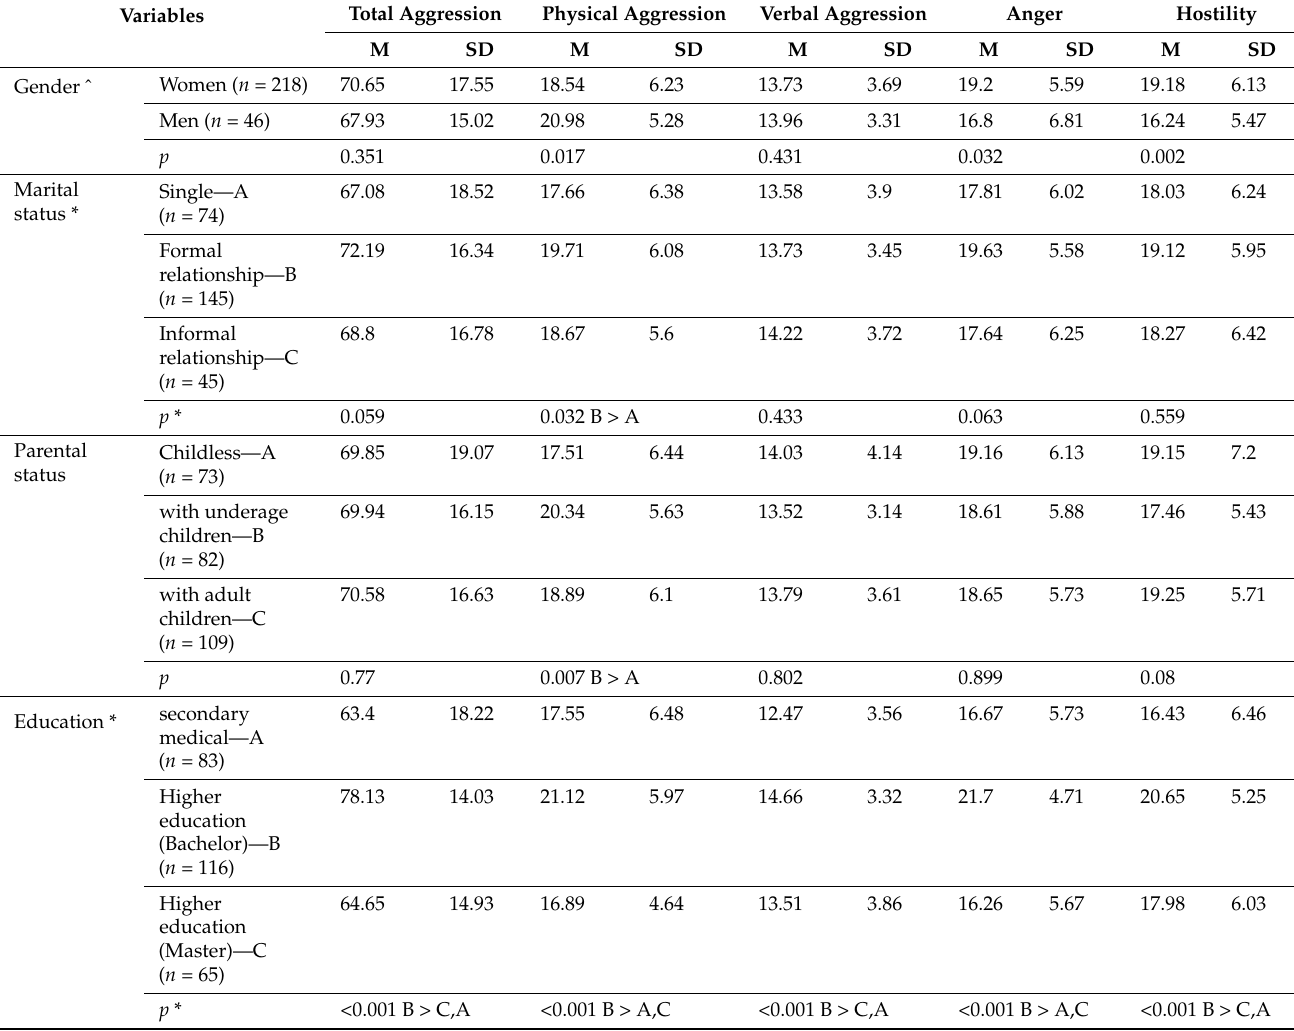
Table 5. The influence of selected sociodemographic variables on